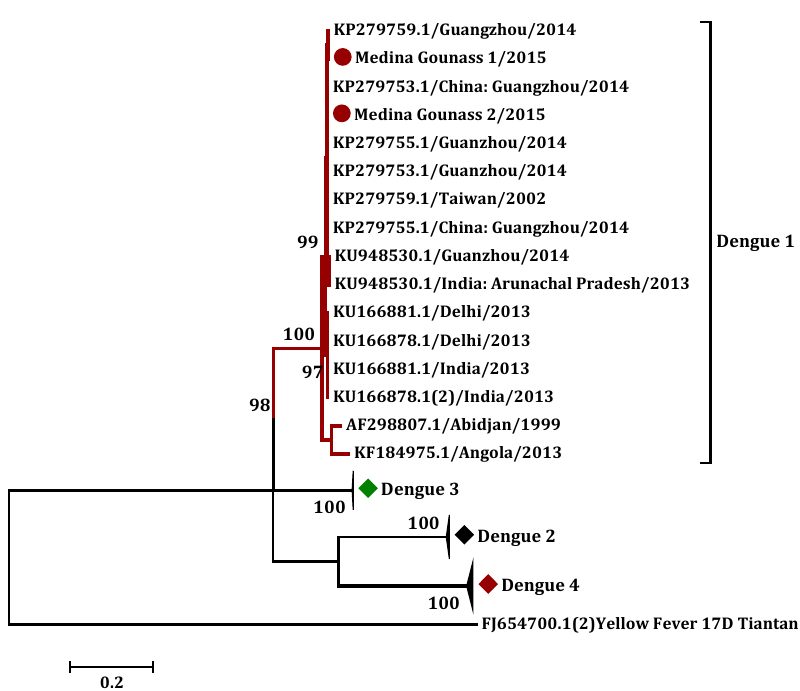
Figure 4. Phylogenetic tree based on the C-prM gene sequences using the maximum likelihood (ML) method, showing the relationship of 2 from 3 isolated viruses in this study (darkred circle) with 40 global samples of dengue virus (DENV), and Kimura 2 parameters; the gamma distributed (K2 + G + I) nucleotide substitution model was used. The yellow fever 17D (FJ654700.1) was used as the outgroup.